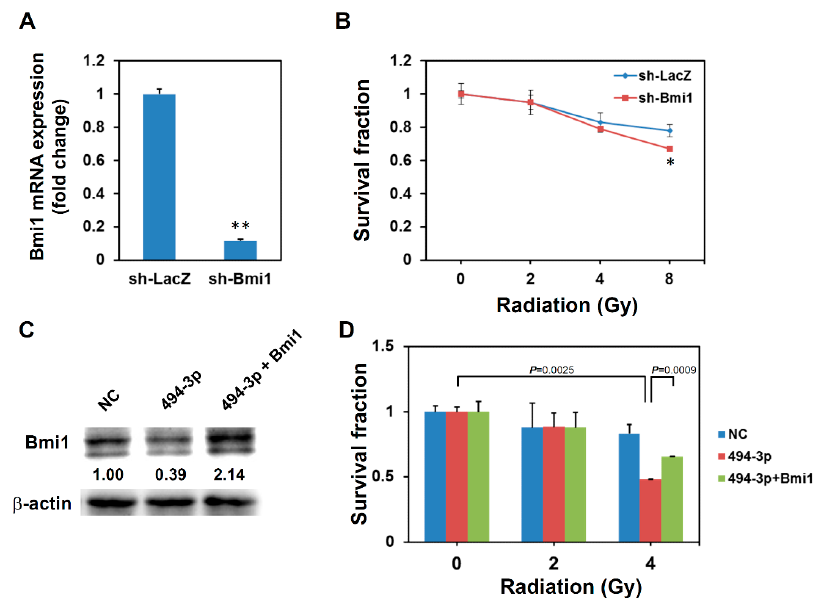
Figure 4. Knockdown of Bmi1 increases radiosensitivity in SAS cells. ( A , B ) SAS cells were transduced with sh-Bmi1 or sh-LacZ carrying lentivirus and selected with 2 μ g/mL puromycin for 3 days. The knockdown efficiency was determined by qPCR detection of Bmi1 mRNA expression ( A ). **, p < 0.01; Transduced cells were irradiated as 2, 4, or 8 Gy and cultured for further 72 h. Cell viability was determined by WST-1 reagent. Data were presented as survival fraction as comparison with non-irradiated cells ( B ). *, p < 0.05; ( C , D ) SAS cells were transfected with pcDNA3-Bmi1 vector with miR-494-3p mimic (494-3p). A negative control mimic (NC) was used as control. After 48 h, cells were harvested for determination of the Bmi1 expression by Western blot ( C ) and the radiation responses of SAS cells ( D ).